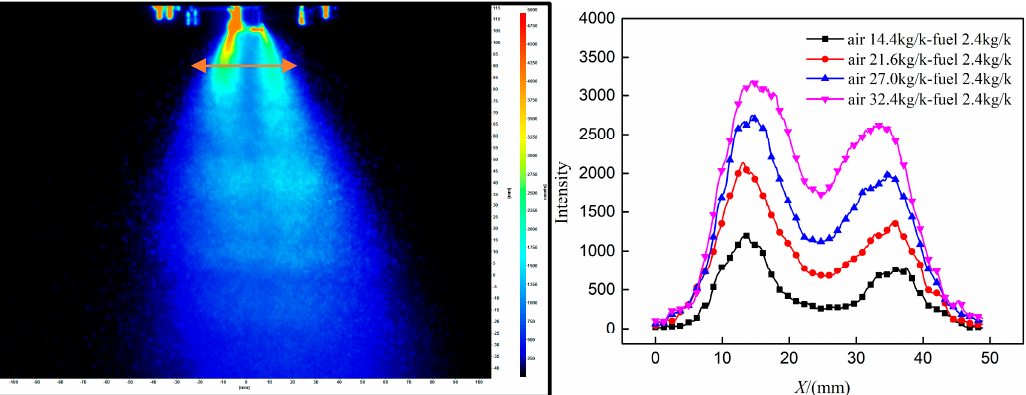
Figure 15. The influence of air mass rate on fuel distribution at a distance of 15 mm from the swirler exit in the y -direction (Case B).